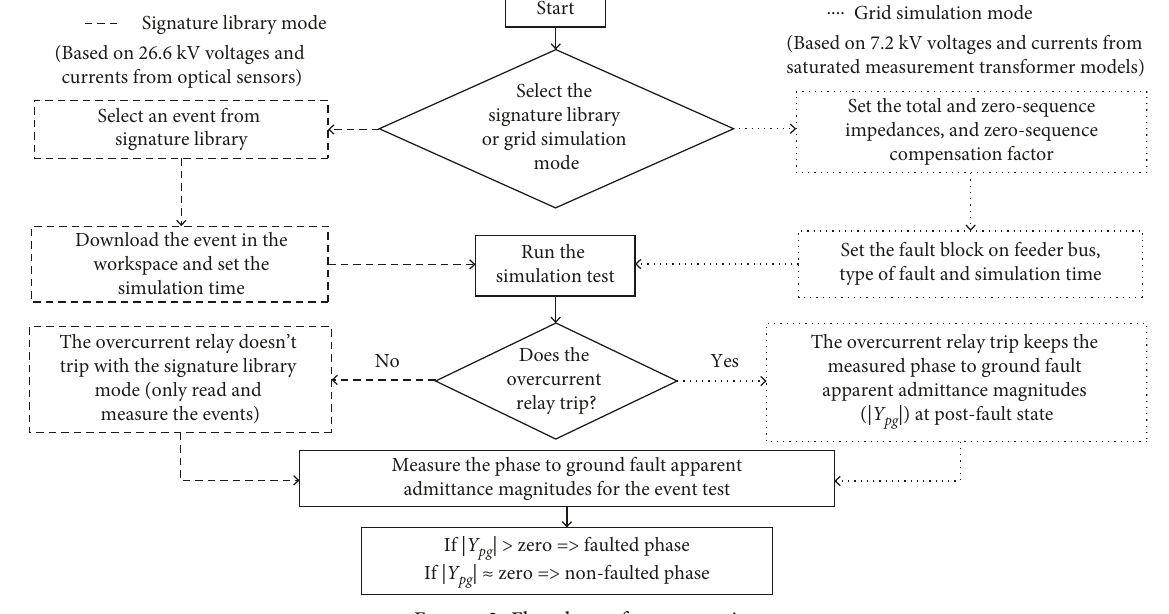
Figure 2: Flowchart of test Table 2: Signature library events and states.